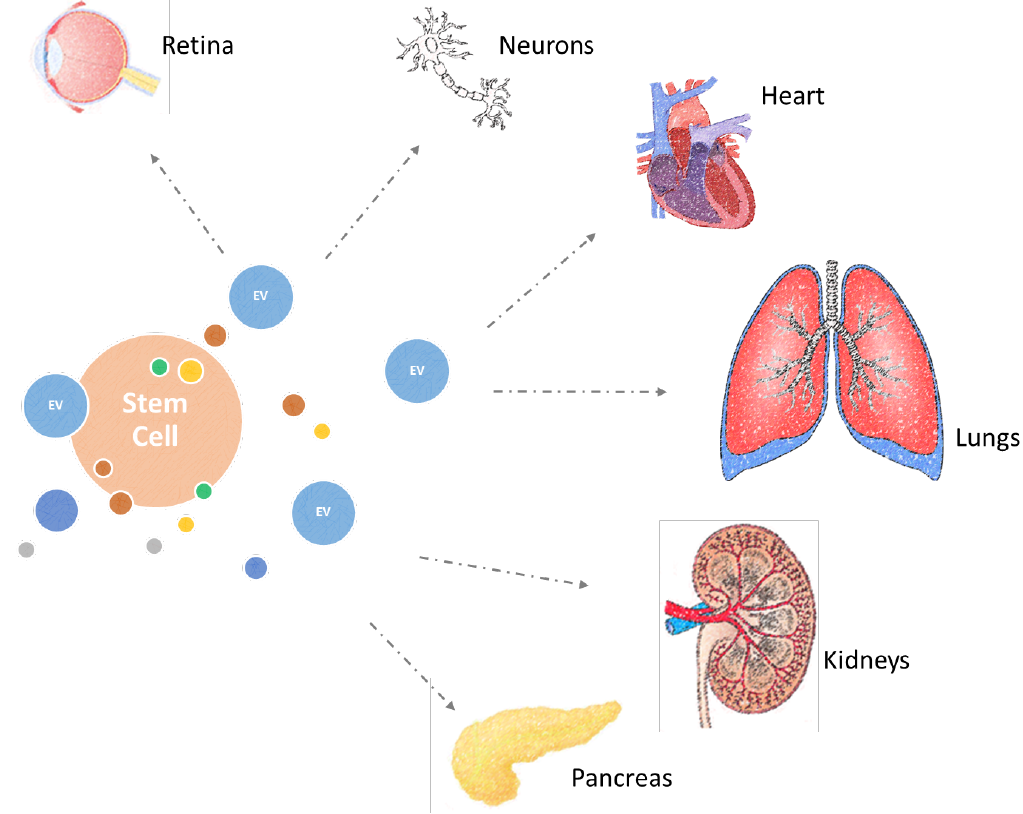
Figure 3. Extracellular vesicles (EV) and their therapeutic applications. Ageing results in loss of functional capacity in a number of key organs. Microvesicles, derived from stem cells or stem cell regulatory cell types, such as Pathfinder cells, can become a novel cell-free therapeutic intervention to mitigate the undesirable effects of ageing by enhancing tissue regeneration and thus improving the human health span.